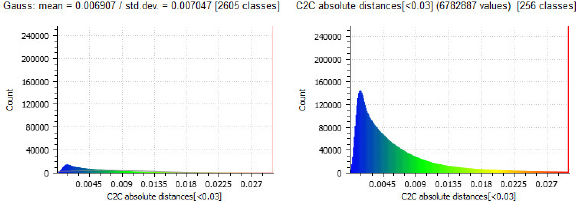
Figure 8. Point clouds of GoPro photogrammetric survey. Compared distance with points cloud obtained with Nikon D610.